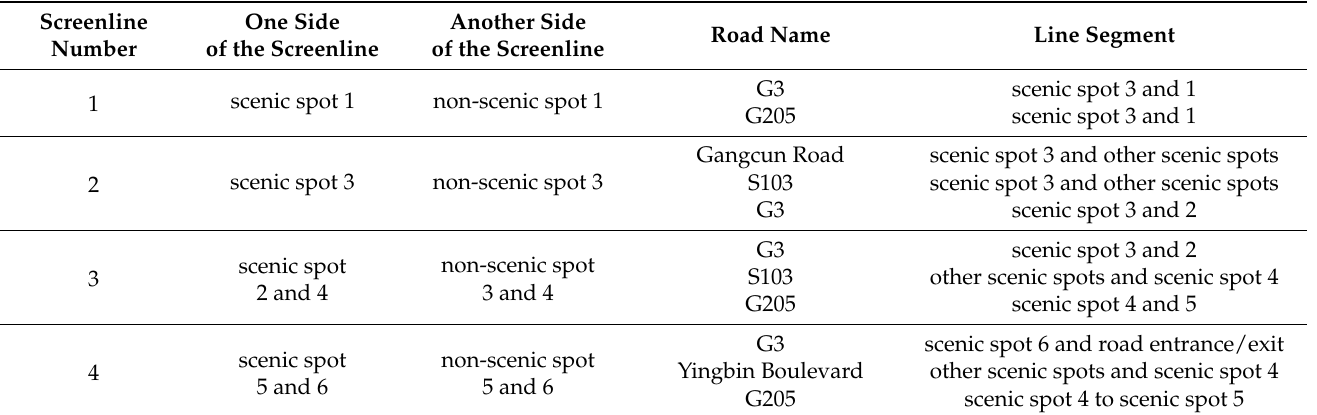
Table 7. Areas separated by screenlines.